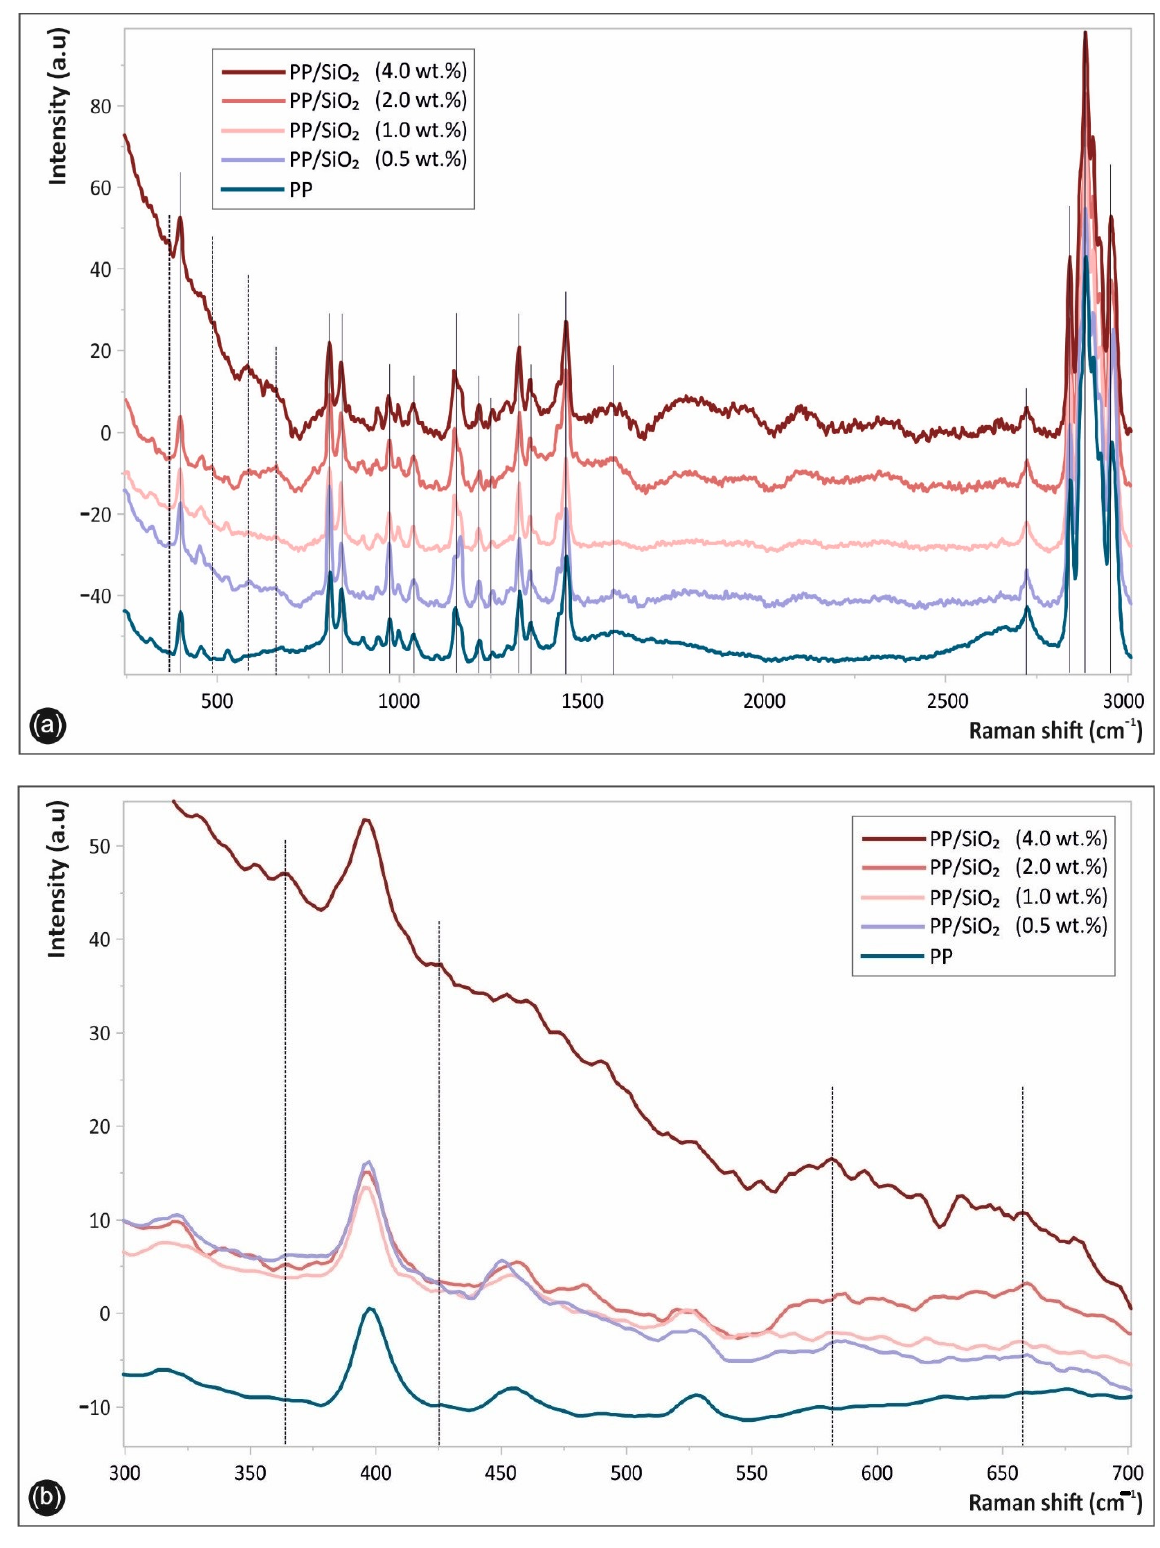
Figure 7. Raman spectra of 3D printed samples, namely the pure PP, as well as the PP/SiO 2 nanocomposites at different filler loadings, in the spectral region of ( a ) 250–3000 cm − 1 , as well as ( b ) 300–700 cm − 1 , respectively.